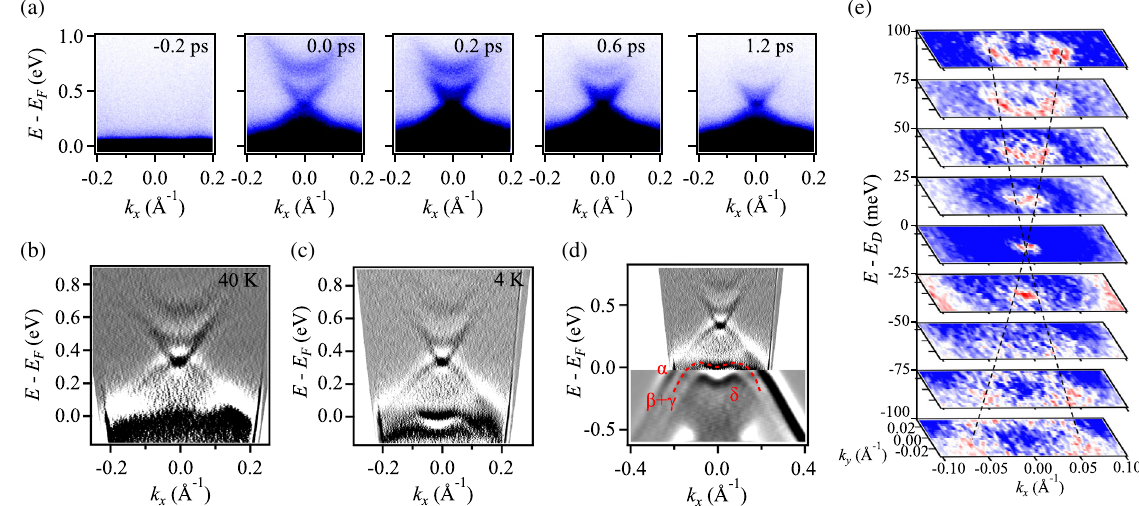
¯ Γ ¯ M - taken with the